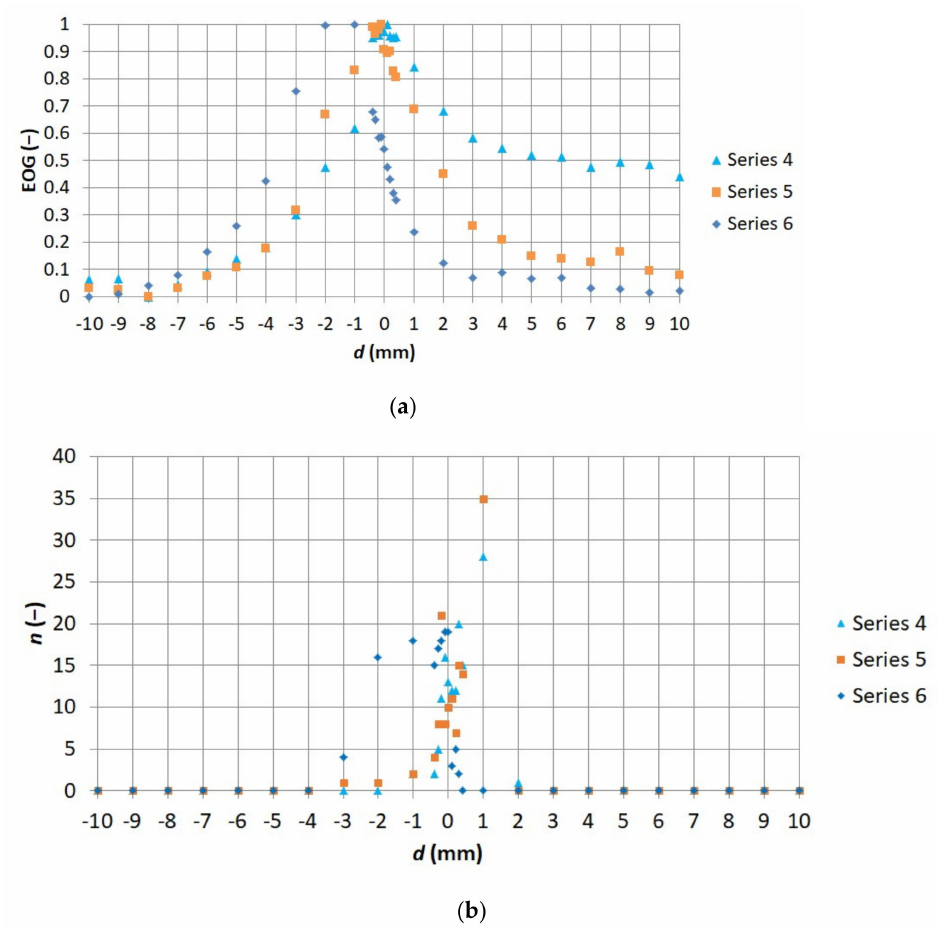
Figure 9. Comparison of relationship ( a ) between EOG measure of sharpness and distance between 1–3 ( b ) between numbers of thermograms indicated by observers as sharp n and distance between the thermographic camera lens and observed